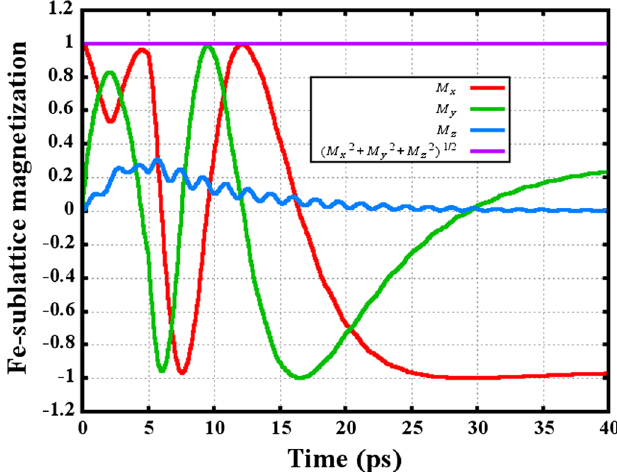
FIG. 2. The time evolution of the x , y , and z components of the topmost Fe-sublattice magnetization of the trilayer shown in Fig. 1. In addition, the magnitude of the magnetization is also shown. We have used H x ¼ 3 T , H z ¼ 5 T , j K j ¼ 0 : 06 mRy , and (cid:2) ¼ 0 : 02